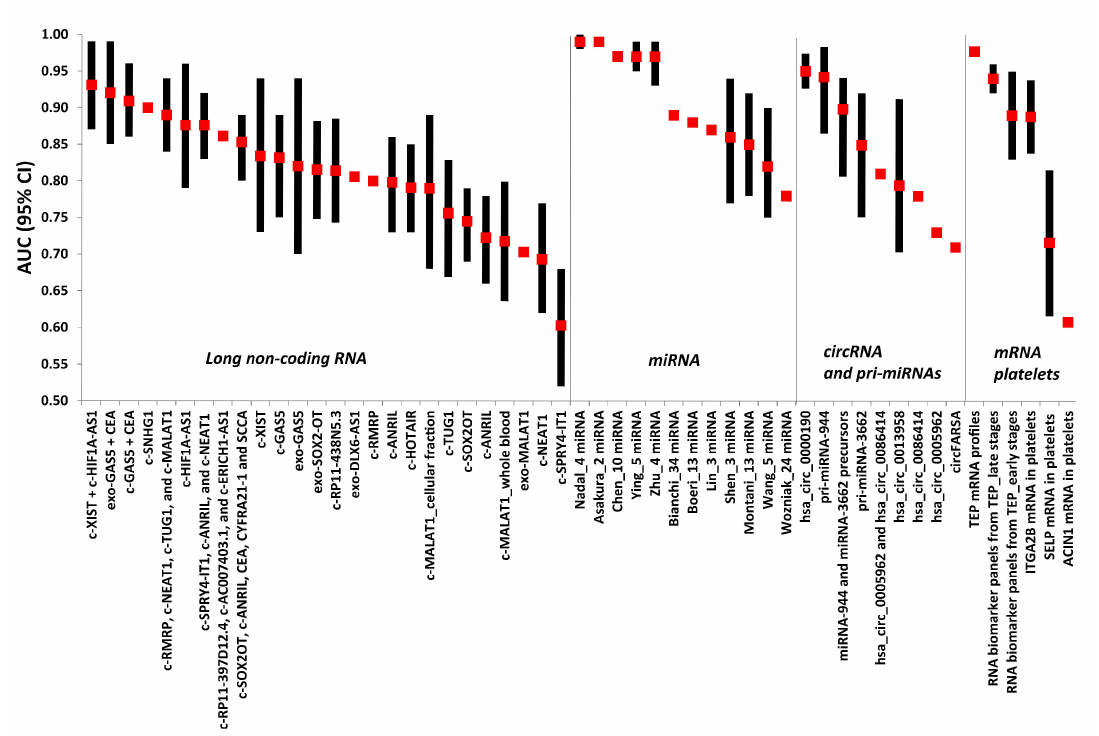
Figure 2. Forest plot showing the AUC and 95% confidence interval (when reported) for c-miRNA-based signatures (listed in Table 1) and other RNA-based biomarkers (listed in Tables S2–S4). Red squares represent the AUC for each marker and black vertical bars extend from the lower limit to the upper limit of the 95% confidence interval (95%